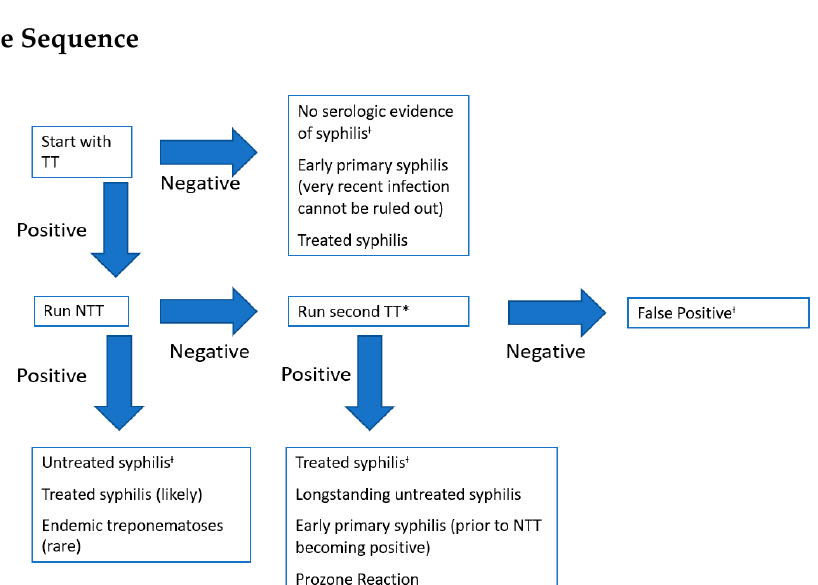
Figure 4. Traditional and reverse sequence algorithms for maternal serologies. NTT = Non-treponemal test. TT = Treponemal test. * = The confirmatory TT must be different from the initial TT. Ɨ = The likely or most likely interpretation of the test results.